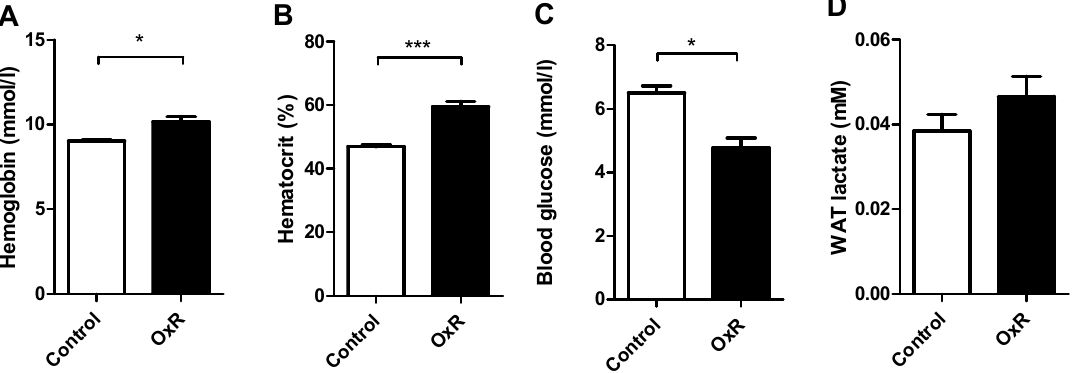
resistant state.